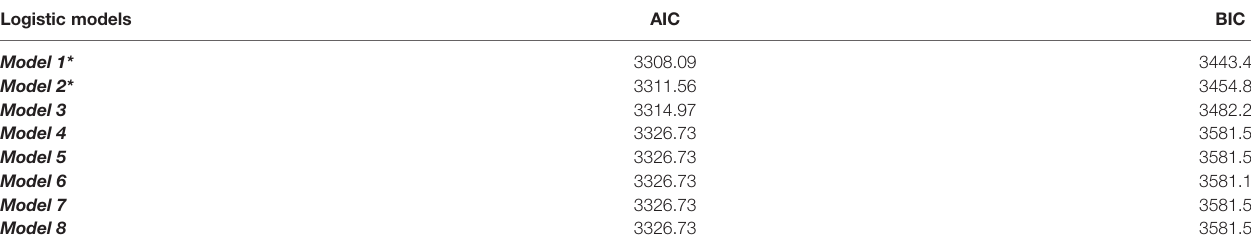
*Shows best models according to